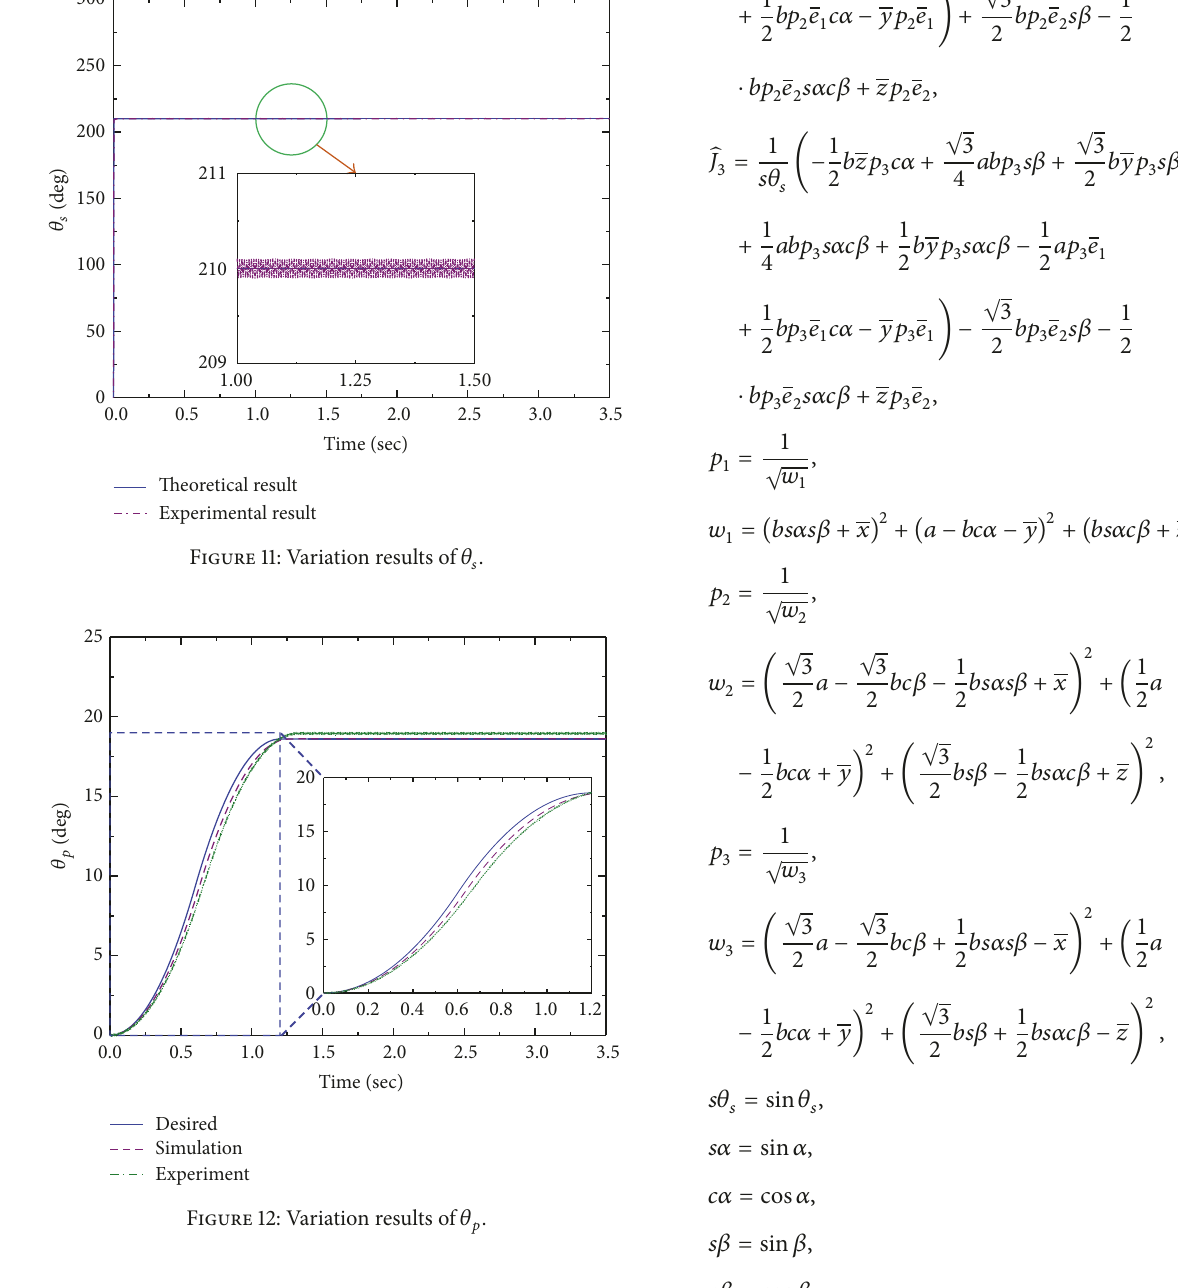
Figure 12: Variation results of 𝜃 𝑝